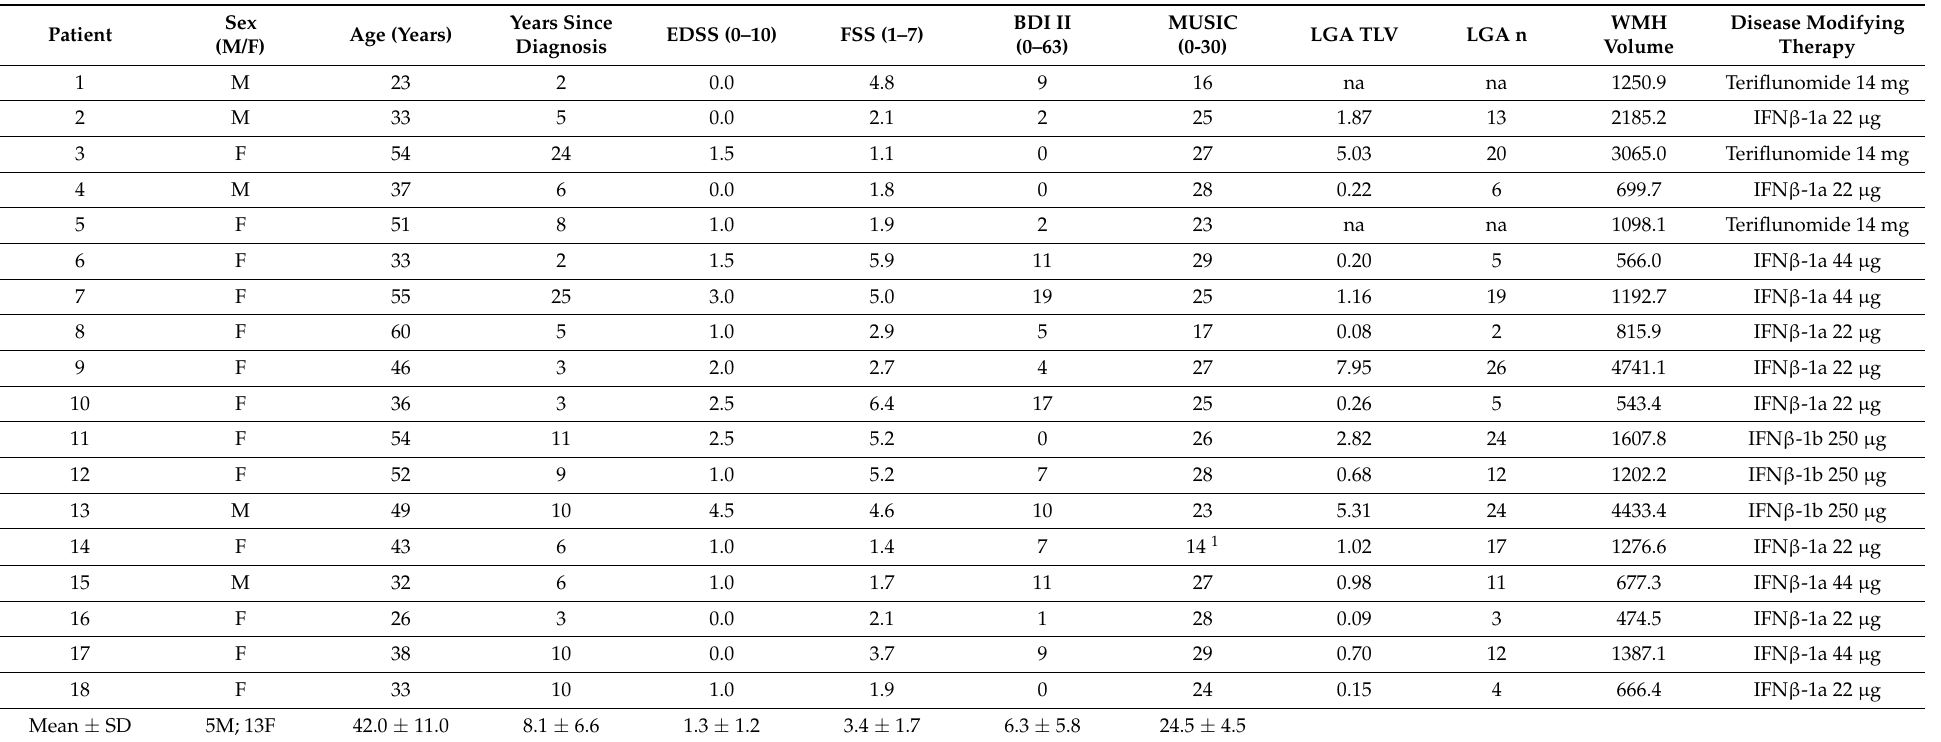
Table 1. Patient’s